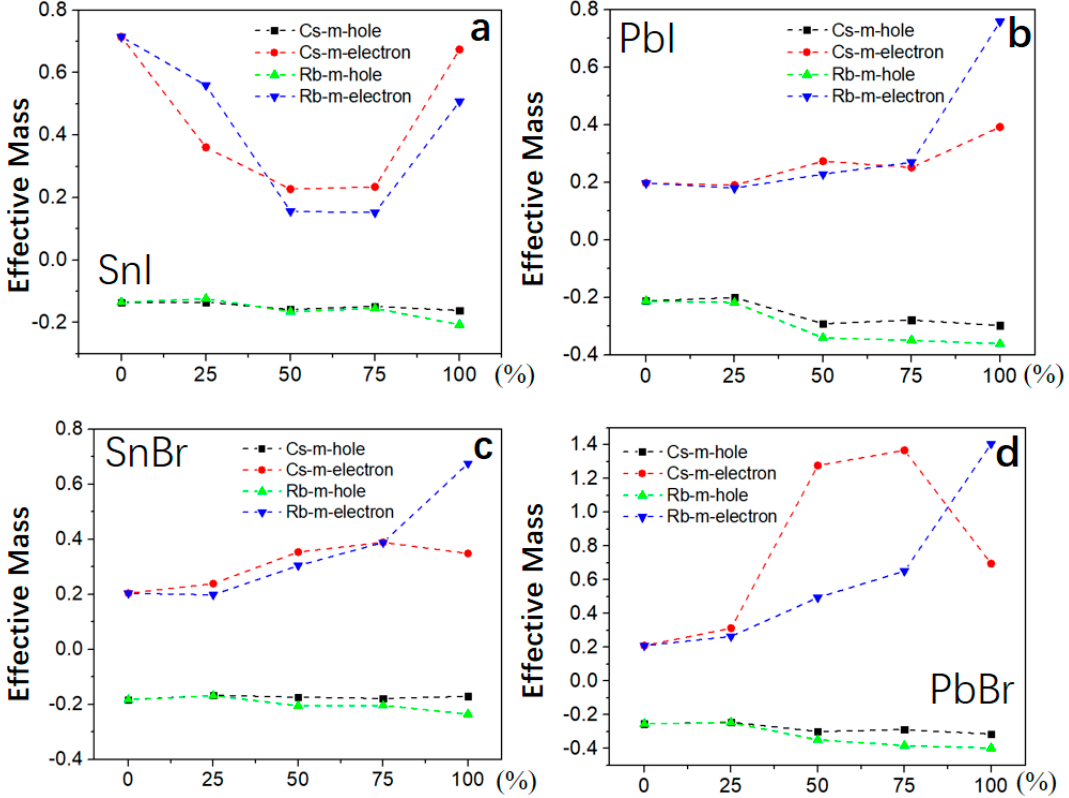
Figure 4. Carrier effective mass for 2D-HOIPs by mixing Cs/Rb atom at different concentrations (0%, 25%, 50%, 75% and 100%): ( a ) SnI-2D-HOIPs, ( b ) PbI-2D-HOIPs, ( c ) SnBr-2D-HOIPs, and ( d ) PbBr- 2D-HOIPs.